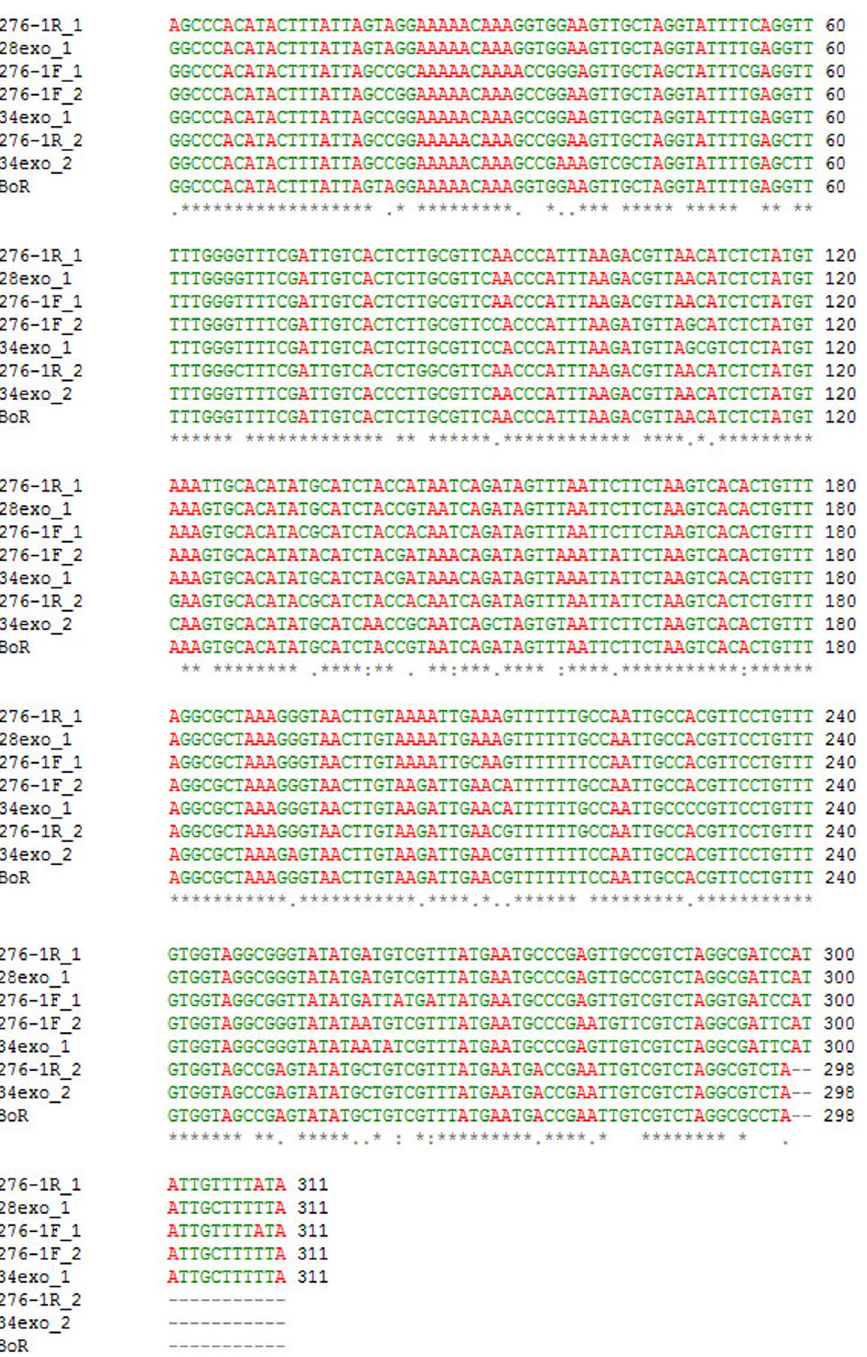
Figure 2. Variability of BoR300. Multiple sequence alignment of different BoR300 units obtained from the terminal sequence reads of the original 8-kb p276-1 clone and two internal subclones (pExo34, pExo28) derived from ExoIII serial deletions of p276-1. In addition, a HaeIII cloned BoR300 unit (originated from clone pExo34) is also included. The corresponding name-code of each repeat and the respective subclone of its origin were as follows: i) right end of p276-1:276-1F_1 and 276-1F_2, ii) left end of p276-1:276-1R_1 and 276-1R_2, iii) left end of the subclone pExo34:34exo_1 and 34exo_2, iv) left end of the subclone pExo28:28exo_1, v) sequence of the BoR300 unit: BoR300.